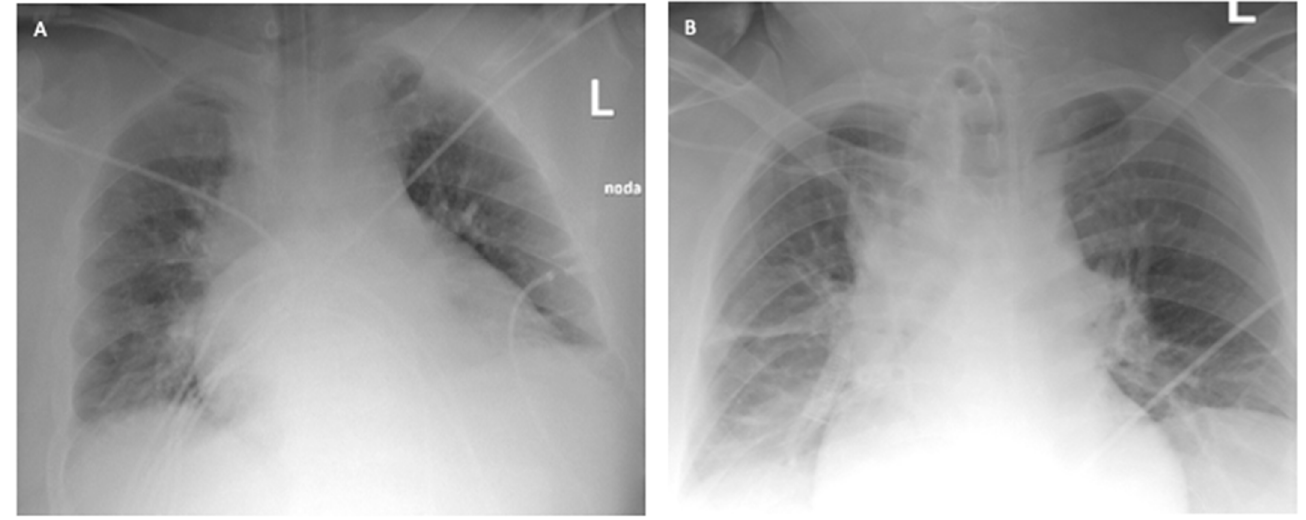
Figure 4. Chest X-ray: ( A ) after admission to the ICU; ( B ) 2 days after starting VV ECMO treatment (Case 2).